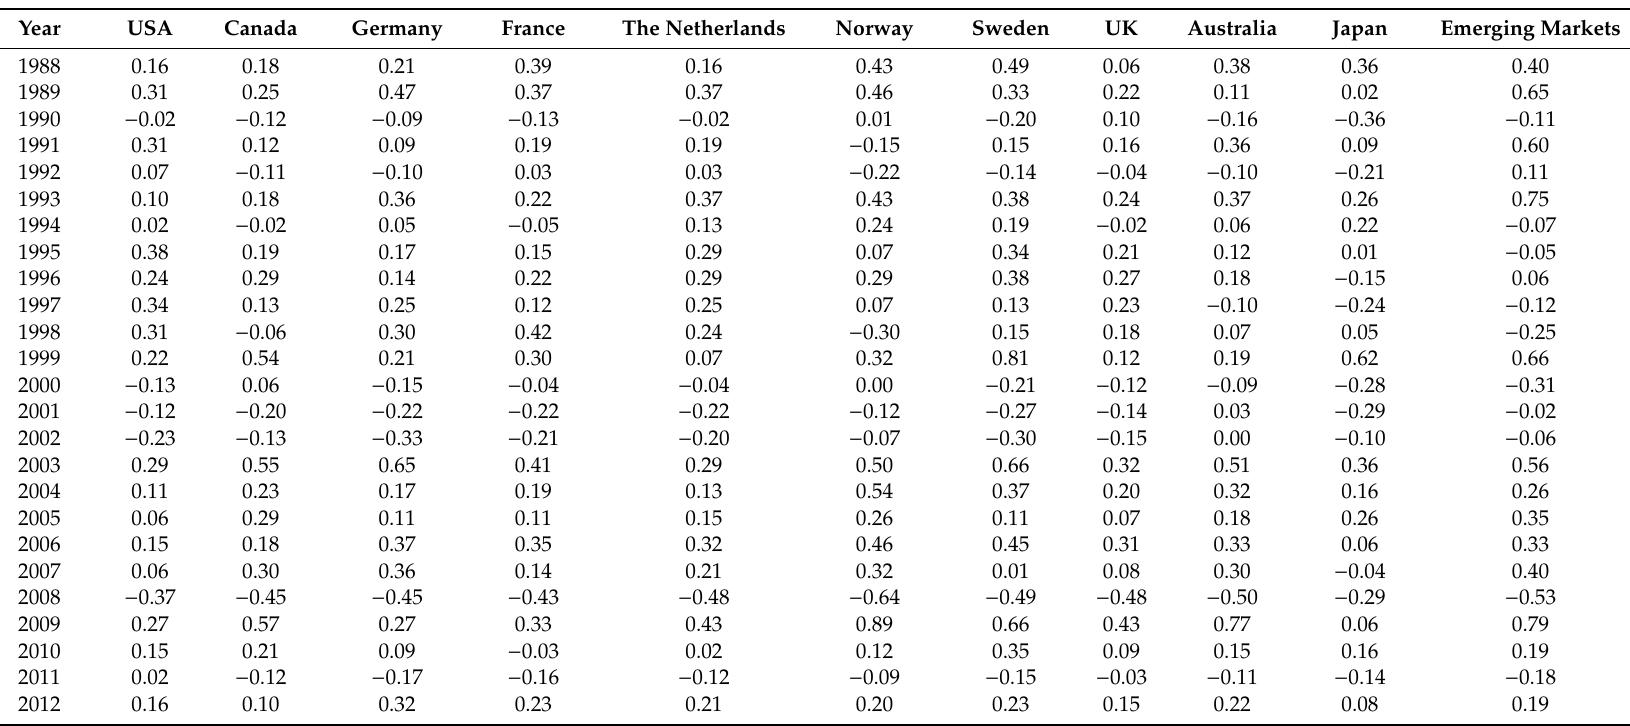
Table A1. The annual rates of return